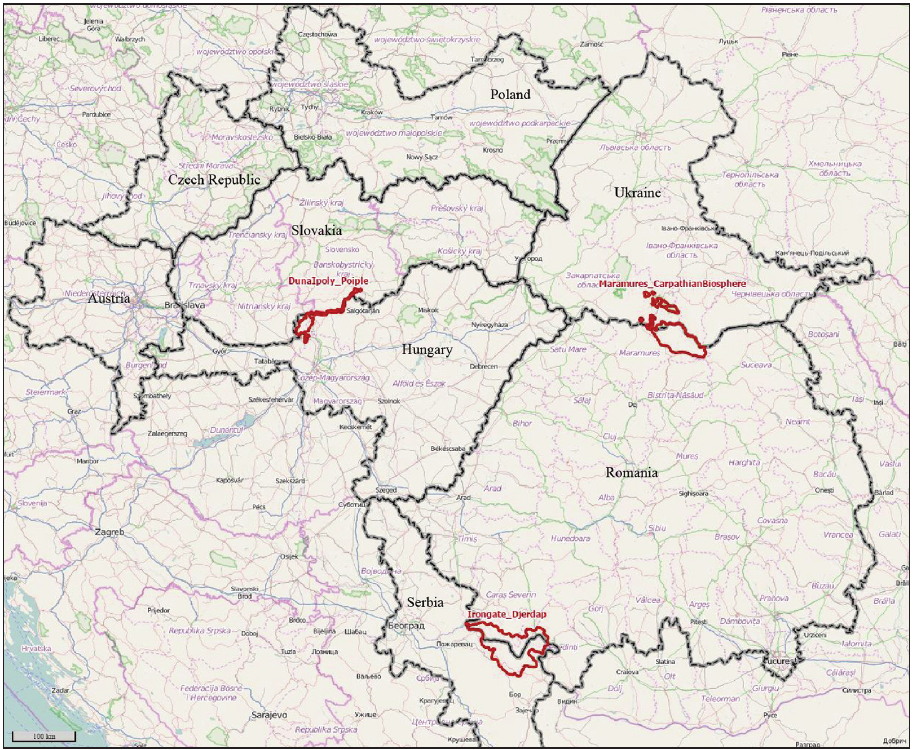
Figure 1. Web-GIS screenshot showing the BioREGIO Study site and Pilot Areas. The red polygons represent the selected national/nature parks (from